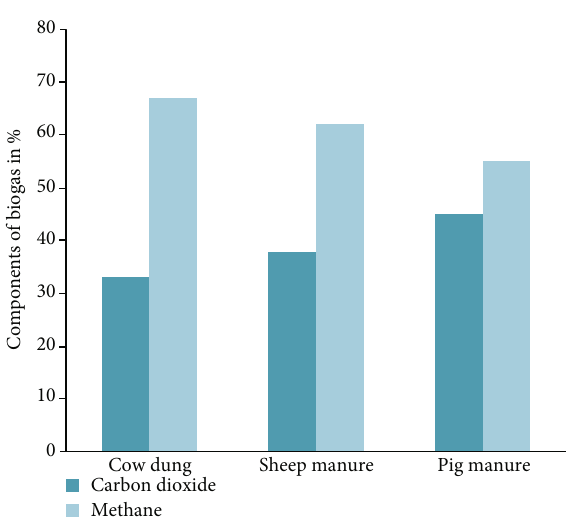
Figure 2: Biogas production rate, size, and item of digesters.